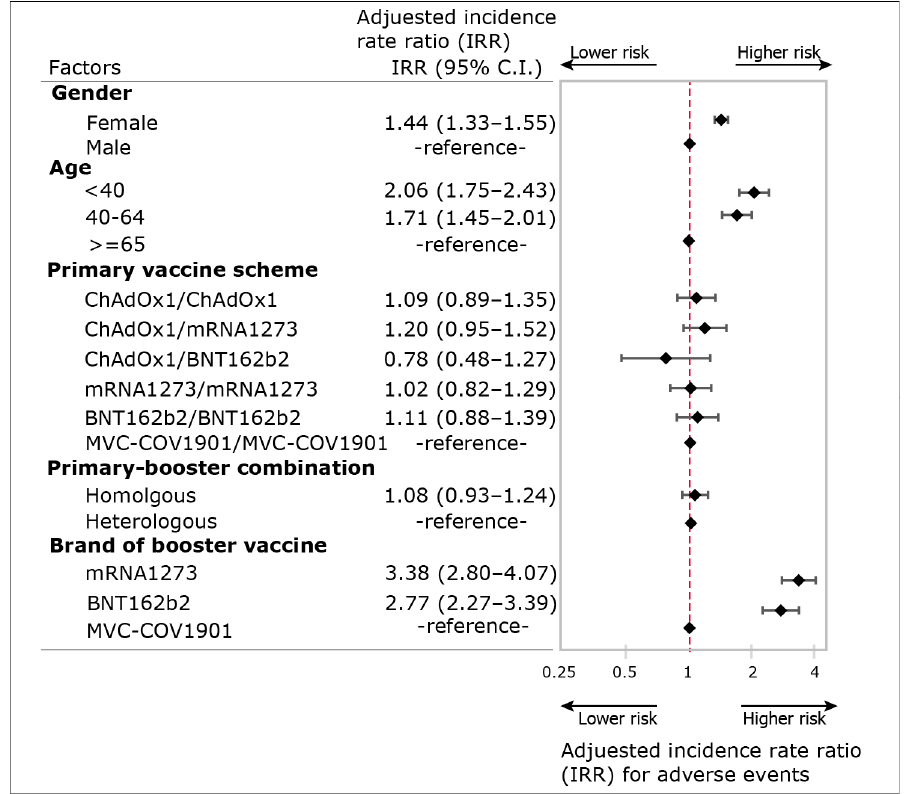
Figure 2. Adjusted incidence rate ratio (IRR), 95% confidence interval (95% C.I.) and forest plot of factors for adverse events (AE) reported to hospital-based vaccine adverse event reporting system (VAERS) for persons who respond to a booster dose of the COVID-19 vaccine from 13 December 2021 to 13 March 2022, at the vaccination station of the Taipei Veterans General Hospital, Taipei, Taiwan. (n = 7382, Taipei, Taiwan).